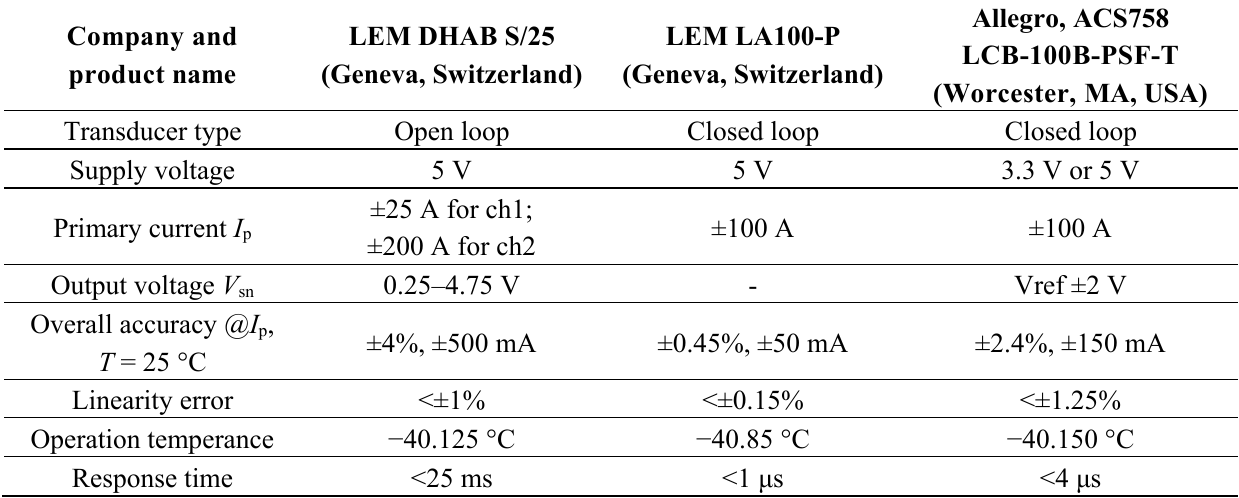
Table 7. The accuracy information comparison of three typical current sensors.